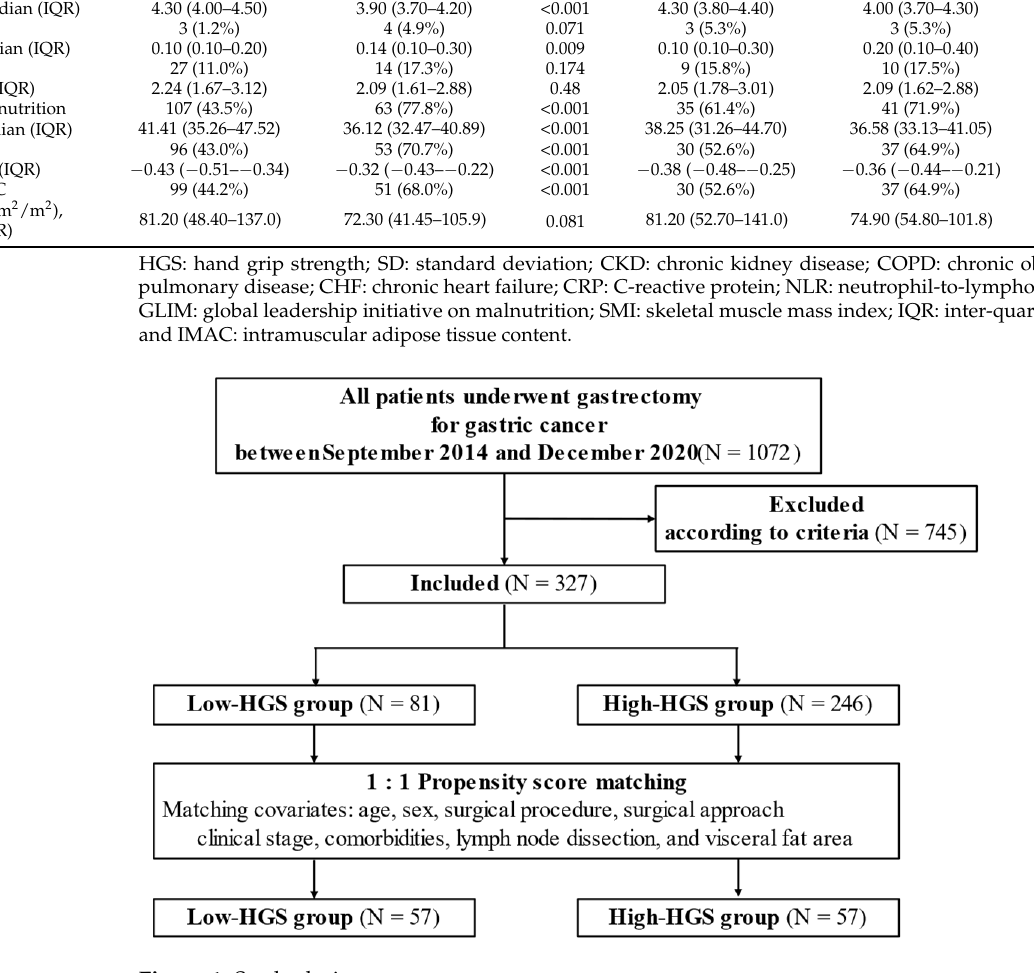
Table 2. Patient characteristics before and after propensity score matching.